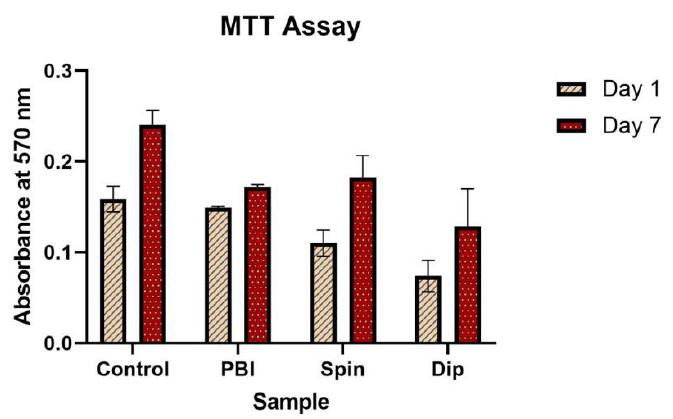
Figure 3. MTT assay results performed after 1 and 7 days of hBM-MSCs culture on the three types of scaffolds: pristine electrospun PBI fibers, PEDOT:PSS-spin coated PBI fibers and PEDOT:PSS-dip coated PBI fibers. Tissue culture plates were used as controls. Results are expressed as mean ± standard deviation ( n = 3 independent samples).